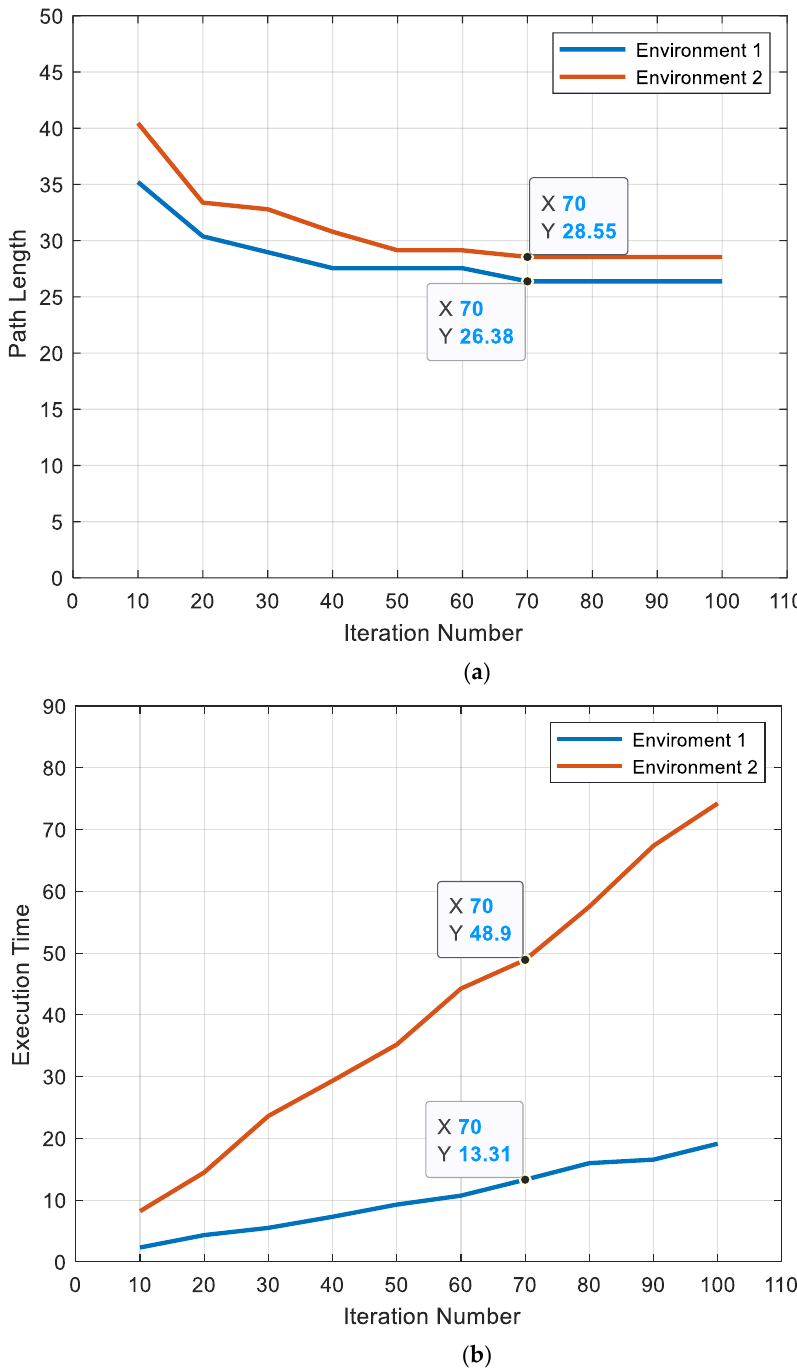
Figure 9. Effect of the number of iterations on ( a ) path length and ( b ) execution time for environment 1 and environment 2.